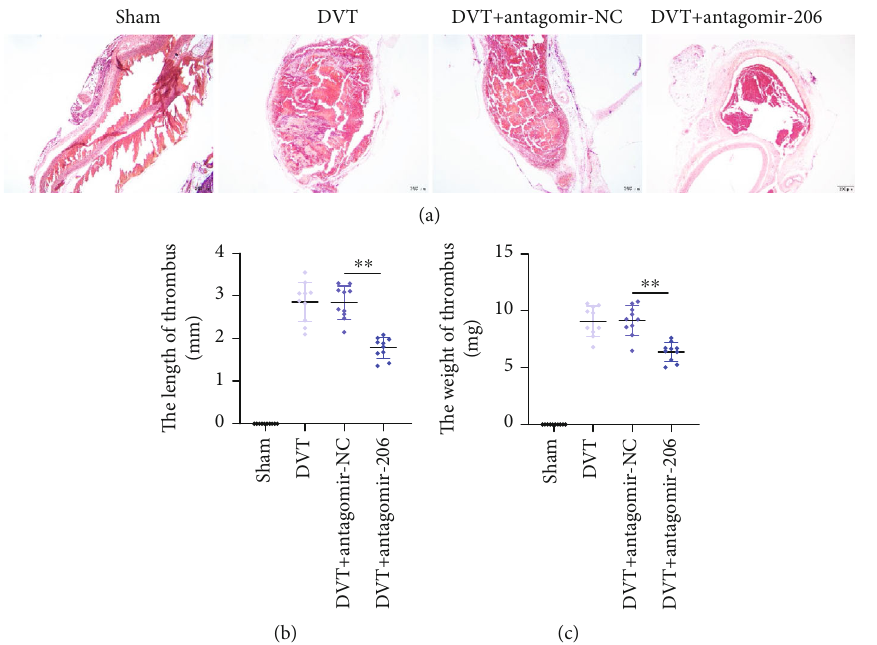
Figure 5: miR-206 knockdown alleviates thrombus formation in mice with DVT. (a) The pathological changes were observed through the HE staining of serial cross sections of IVC at 24h postoperation from mice in Sham, DVT, DVT+antagomir-NC, or DVT+antagomir-206 groups. (b, c) The length and weight of thrombus at 24h postoperation from mice in the above four groups. n = 10 in each group. ∗∗ p < 0 : 01